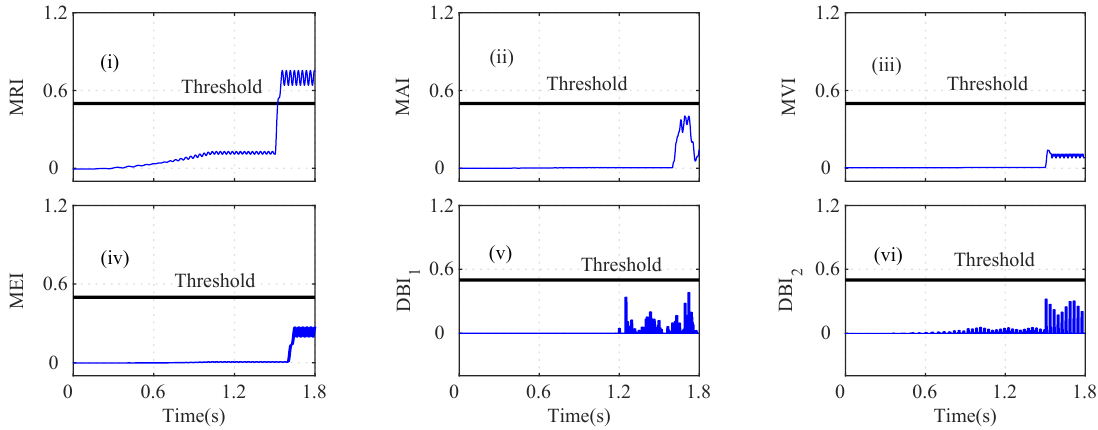
Figure 14. Analysis of residuals for E β using index-based method ((i) MRI, (ii) MAI, (iii) MVI, (iv) MEI, (v) DBI 1 and (vi) DBI 2 ) for the 20% noisy incipient i α fault and abrupt ω e fault scenario at t = 1.25 s and t = 1.50 s, respectively.